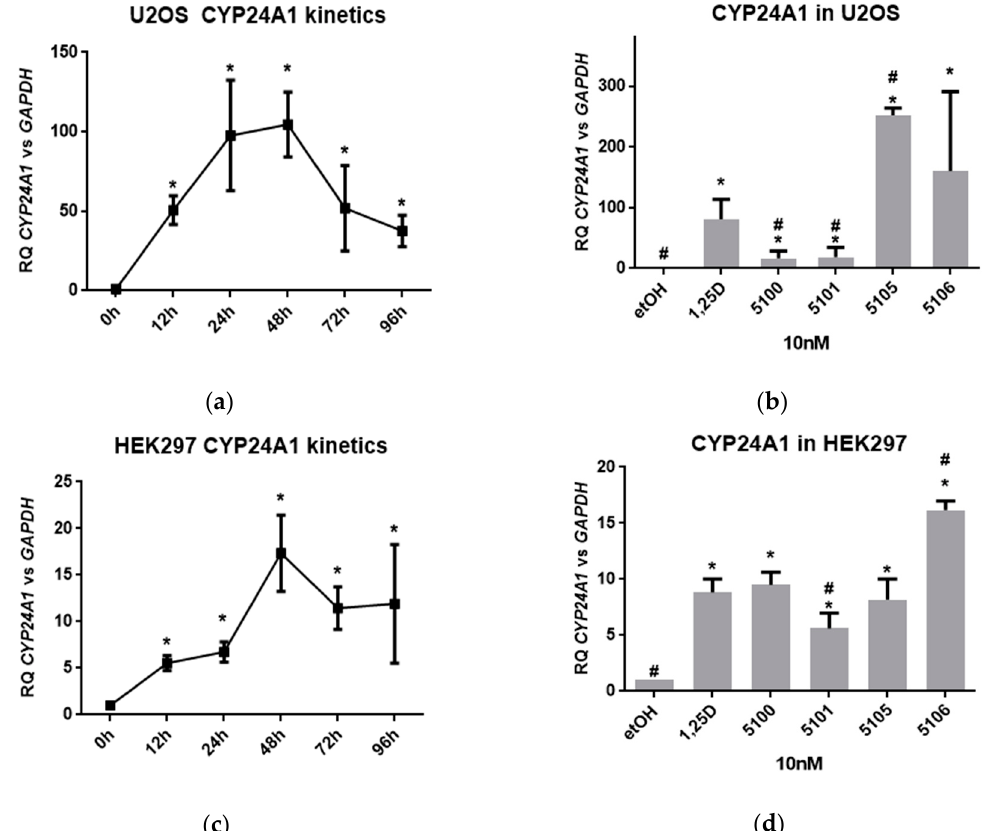
Figure 4. Activities of analogs towards U2OS and HEK297 cells. ( a ) U2OS cells were exposed to 10 nM 1,25D3 for different times and then the expression of CYP24A1 mRNA was measured by real-time PCR. The graph shows mean values (±SD) of the fold changes in mRNA levels relative to GAPDH mRNA levels. Values that differ significantly from those obtained for control cells are marked with *; ( b ) U2OS cells were exposed to 10 nM 1,25D3, or 10 nM analogs, and after 48 h the expression of CYP24A1 mRNA was measured by real-time PCR. The bar charts show the mean values (±SD) of the fold changes in mRNA levels relative to GAPDH mRNA levels. Values that differ significantly from those obtained for control cells are marked with *, while the values that differ significantly from those obtained for 1,25D3-treated cells are marked by #; ( c ) HEK297 cells were exposed to 10 nM 1,25D3 for different time and then the expression of CYP24A1 mRNA was measured by real-time PCR. The graph shows mean values (±SD) of the fold changes in mRNA levels relative to GAPDH mRNA levels. Values that differ significantly from those obtained for control cells are marked with *; ( d ) HEK297 cells were exposed to 10 nM 1,25D3, or 10 nM analogs and after 48 h the expression of CYP24A1 mRNA was measured by real-time PCR. The bar charts show the mean values (±SD) of the fold changes in mRNA levels relative to GAPDH mRNA levels. Values that differ significantly from those obtained for control cells are marked with *, while the values that differ significantly from those obtained for 1,25D3-treated cells are marked by #.